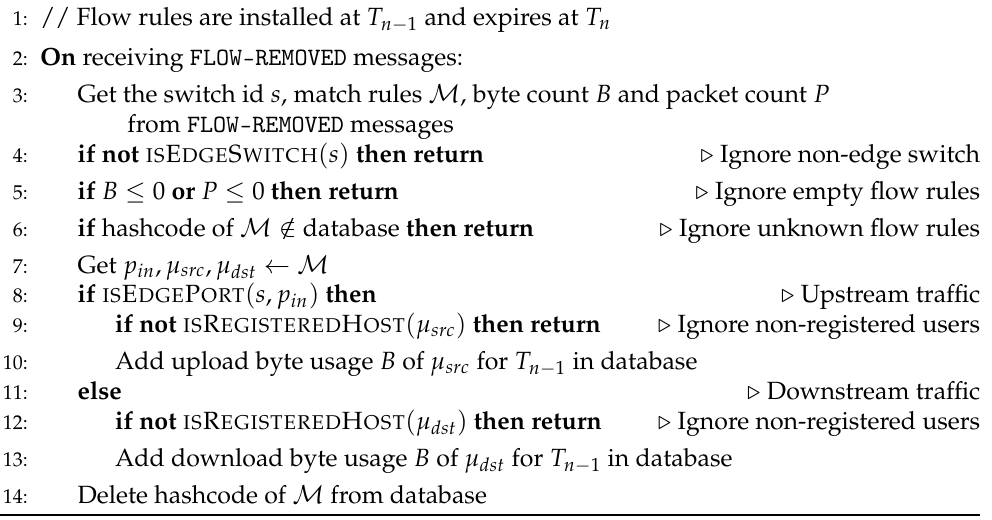
Algorithm 3 The usage tracker module’s